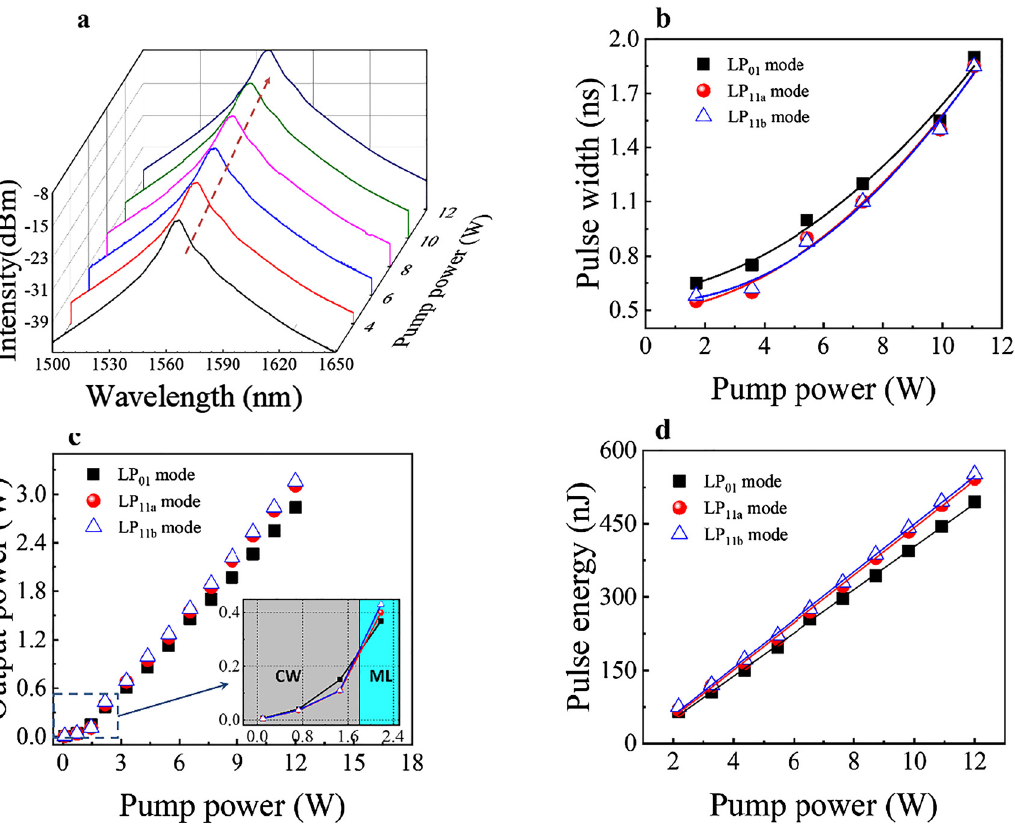
Figure 9: (a) The optical spectral evolution of LP 11a mode, (b) pulse width, (c) average output power of output 2, and (d) pulse energy as the pump power